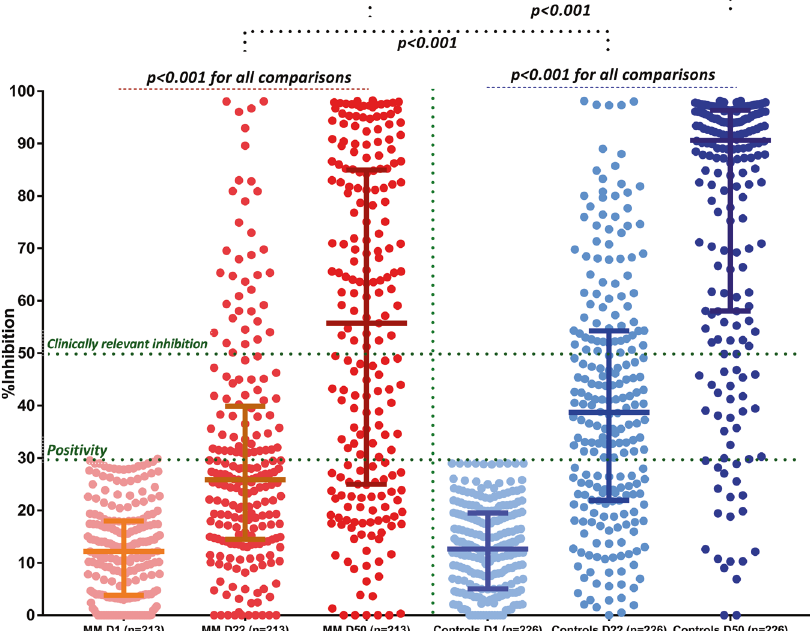
Fig. 2 Kinetics of NAbs in patients with symptomatic MM compared with age- and sex-matched controls after vaccination with 2 doses of the BNT162b2 or 1 dose of the AZD1222 vaccine. Patients with MM had signi fi cantly lower NAbs titers on day 22 and on day 50 compared with